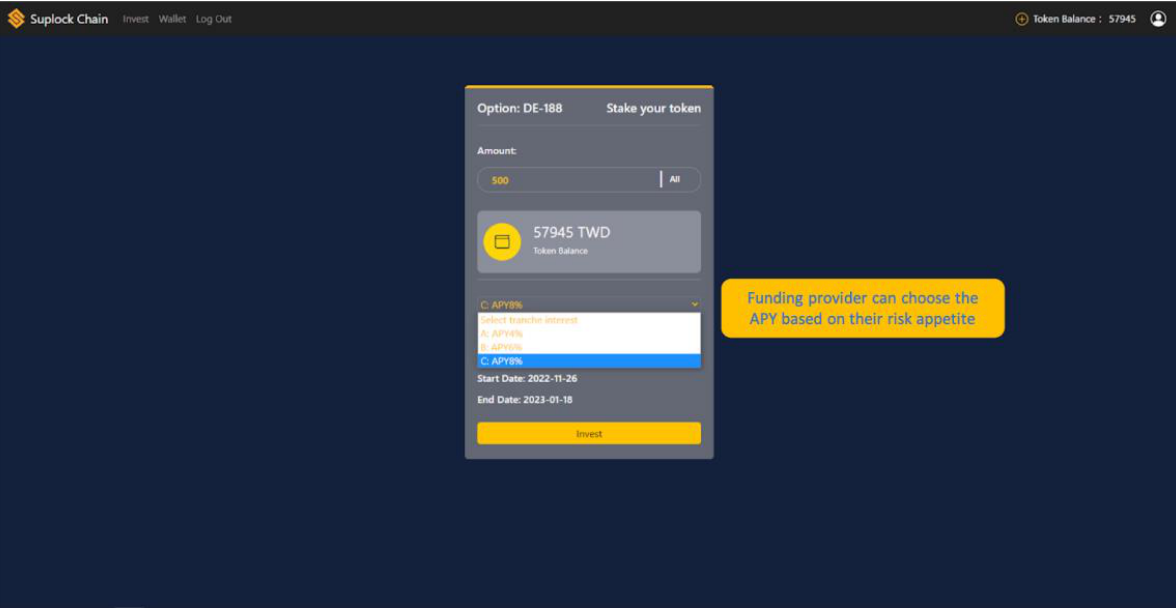
Figure A21. Module for showing right-type CT information on our website.